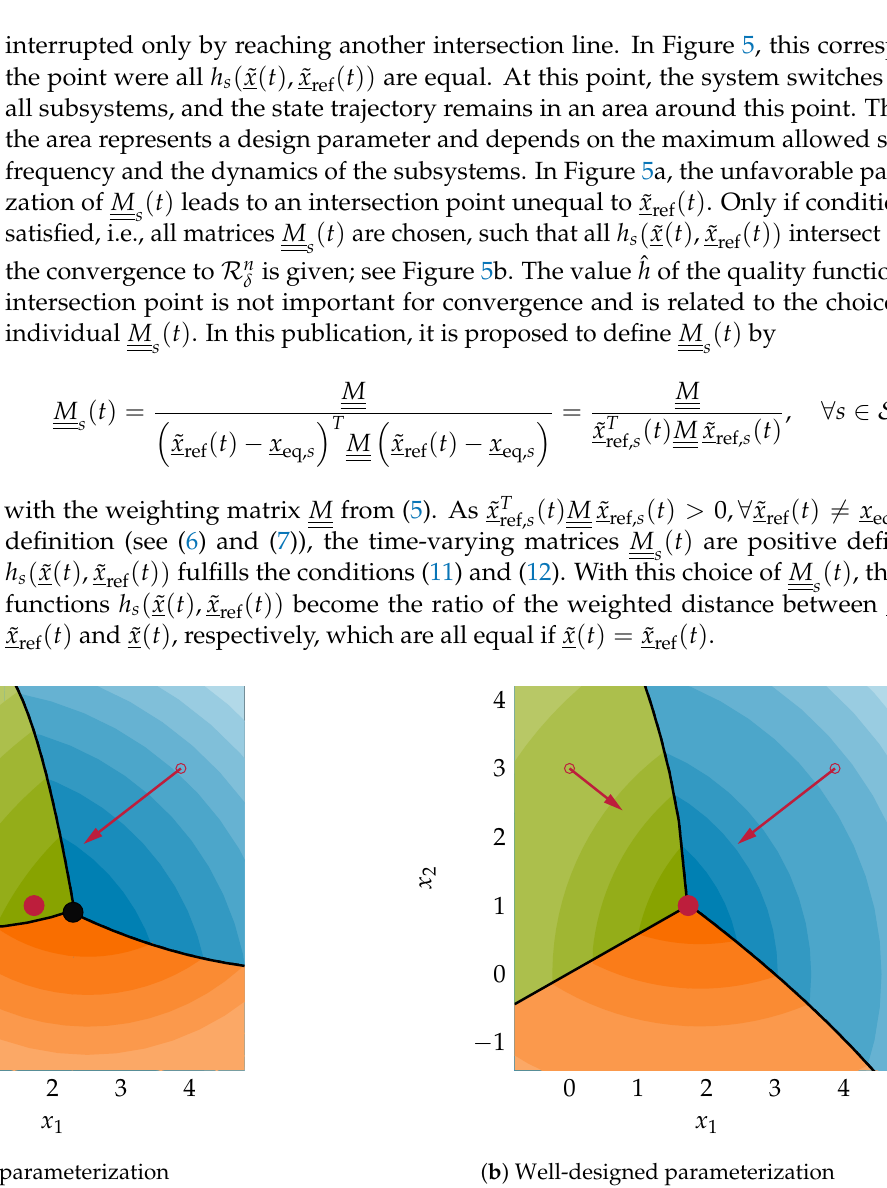
Figure 5. Topview of h s ( ˜ x ( t 0 ) , ˜ x ref ( t 0 )) for all s ∈ S = { 0,1,2 } , intersection point (black dot) and reference trajectory ˜ x ref ( t 0 ) (red dot) with t 0 >